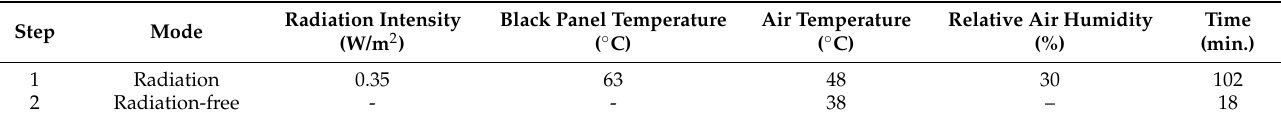
Table 2. The aging parameters set according to the Standard ASTM G 155